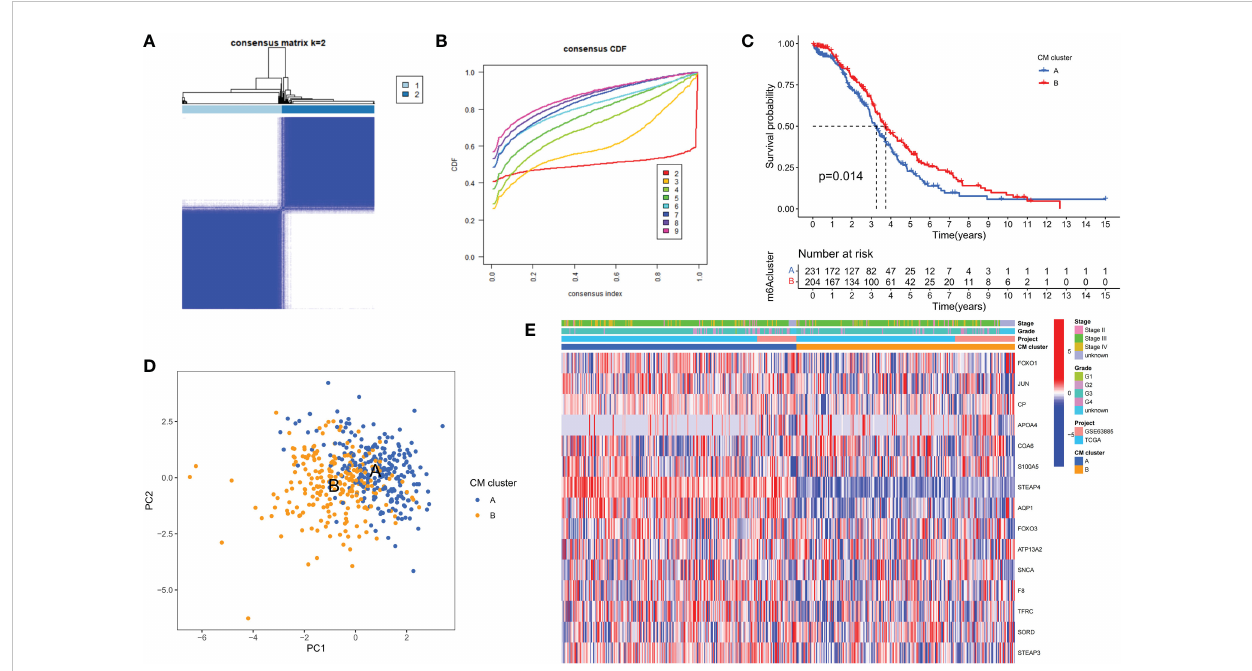
FIGURE 2 Clinicopathological and biological characteristics of the two CM clusters. (A) All samples from the TCGA-OV cohort and the GSE63885 cohort were divided into two clusters using a consensus clustering algorithm (k = 2). (B) The cumulative distribution function (CDF) from k = 2 to 9. (C) Kaplan-Meier curves show the different overall survival (OS) rates between the two CM clusters. (D) Principal component analysis (PCA) shows signi fi cant differences between the two CM clusters. (E) Heat map showing differences in clinical information and expression of CMRGs between the two